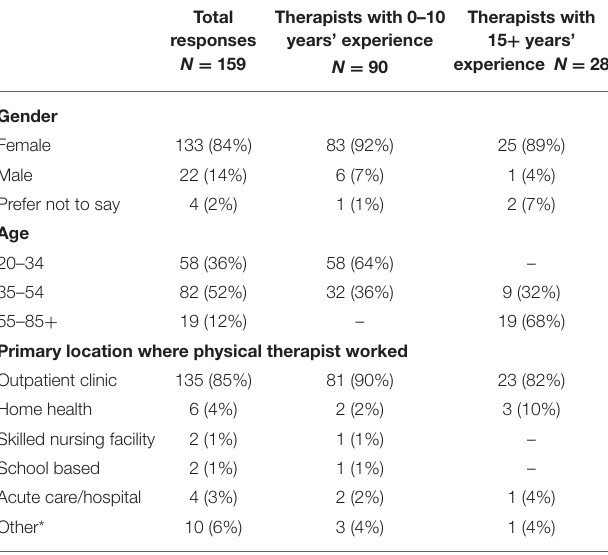
TABLE 1 | Demographic data from the physical therapist who completed the telehealth